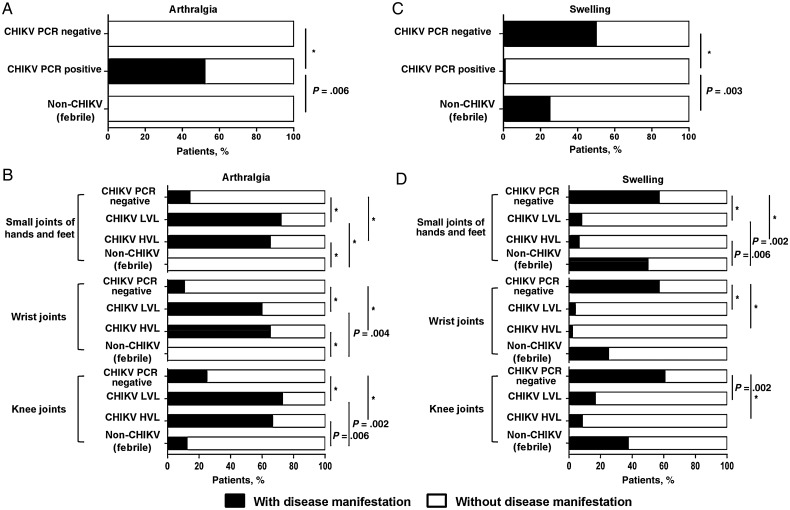
Analysis of chikungunya fever-specific typical disease manifestation from the Sri Lankan patient cohort. Patients were classified as follows: patients with chikungunya virus (CHIKV) infection who were polymerase chain reaction (PCR) positive (positive for viral load detection) (CHIKV PCR positive), patients with CHIKV infection who were PCR negative (negative for viral load detection but positive for CHIKV virion-based or E2EP3-based enzyme-linked immunosorbent assays [ELISAs]) (CHIKV PCR negative), and febrile patients without CHIKV infection (negative both for viral load detection and with CHIKV-based, E2EP3-based ELISAs) (non-CHIKV). A, Histograms show the percentage of patients in each group with or without arthralgia in the various joints (a combination of the small joints of hands and feet, wrist joints, and knee joints). *P < .001. B, The CHIKV PCR-positive patient group was further segregated into high viral load (HVL) and low viral load (LVL) groups before being compared with the CHIKV PCR-negative and non-CHIKV groups for the presence of arthralgia at the various indicated joints. *P < .001. C, Histograms show the percentage of patients in each group with or without swelling in their various joints (small joints of hands and feet, wrist joints, and knee joints). *P < .001. D, Patients in the CHIKV PCR-positive group were further segregated into HVL and LVL groups before being compared with the CHIKV PCR-negative and non-CHIKV groups for the presence of swelling at the various indicated joints. Statistical significance was measured using the 2-sided Fisher exact test and indicated the significance of the contingency between 2 categories of patients. *P < .001.